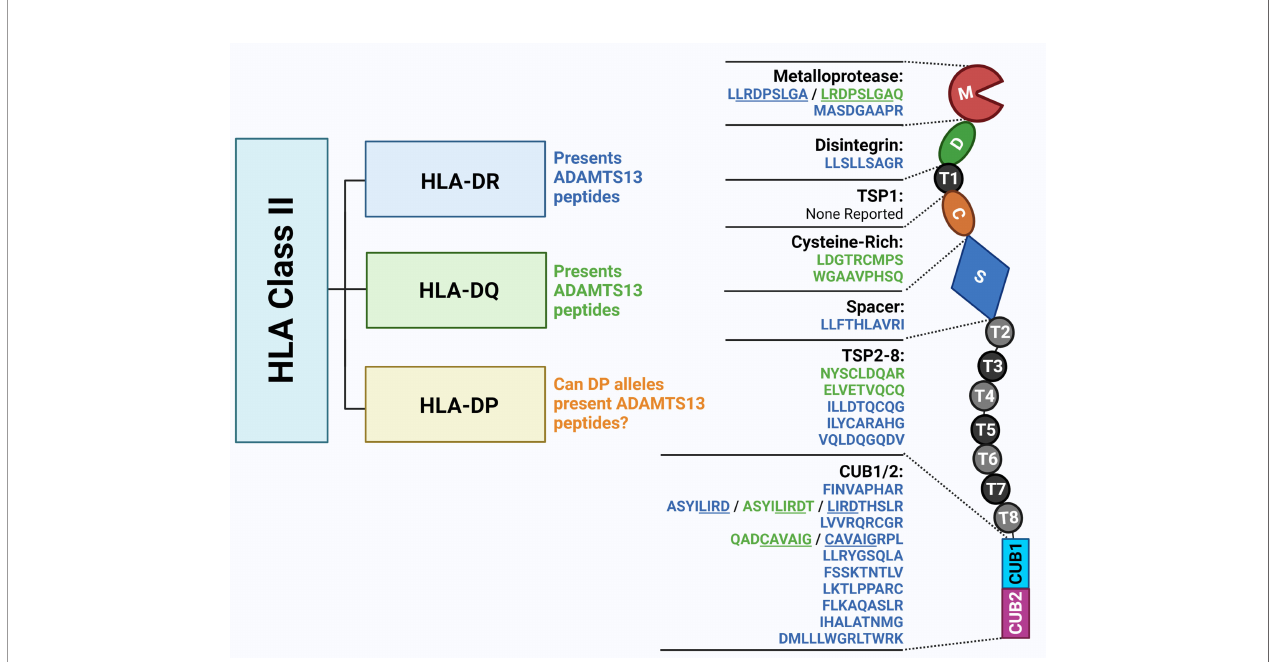
FIGURE 2 | The ADAMTS13 peptidome presented by HLA Class II molecules. Previous studies unravelled ADAMTS13 peptides presented by HLA-DR and HLA- DQ molecules by peptide elution. The monocytes from HLA-DR and HLA-DQ-genotyped healthy donors were isolated and differentiated into dendritic cells (DC). DC were loaded with ADAMTS13, and upon lysis, HLA-II/peptide complexes were isolated by immunoprecipitation. Following elution ADAMTS13-peptides were identi fi ed through mass spectrometry. The 9-mer core sequences of the eluted peptide shown in this fi gure were identi fi ed through NetMHCIIpan 3.1 software (in blue for HLA-DR alleles and in green for HLA-DQ alleles) (63, 64). Figure created with